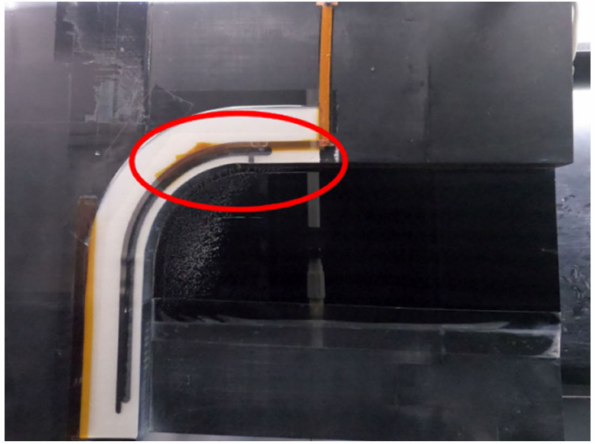
Figure 30. Masking process